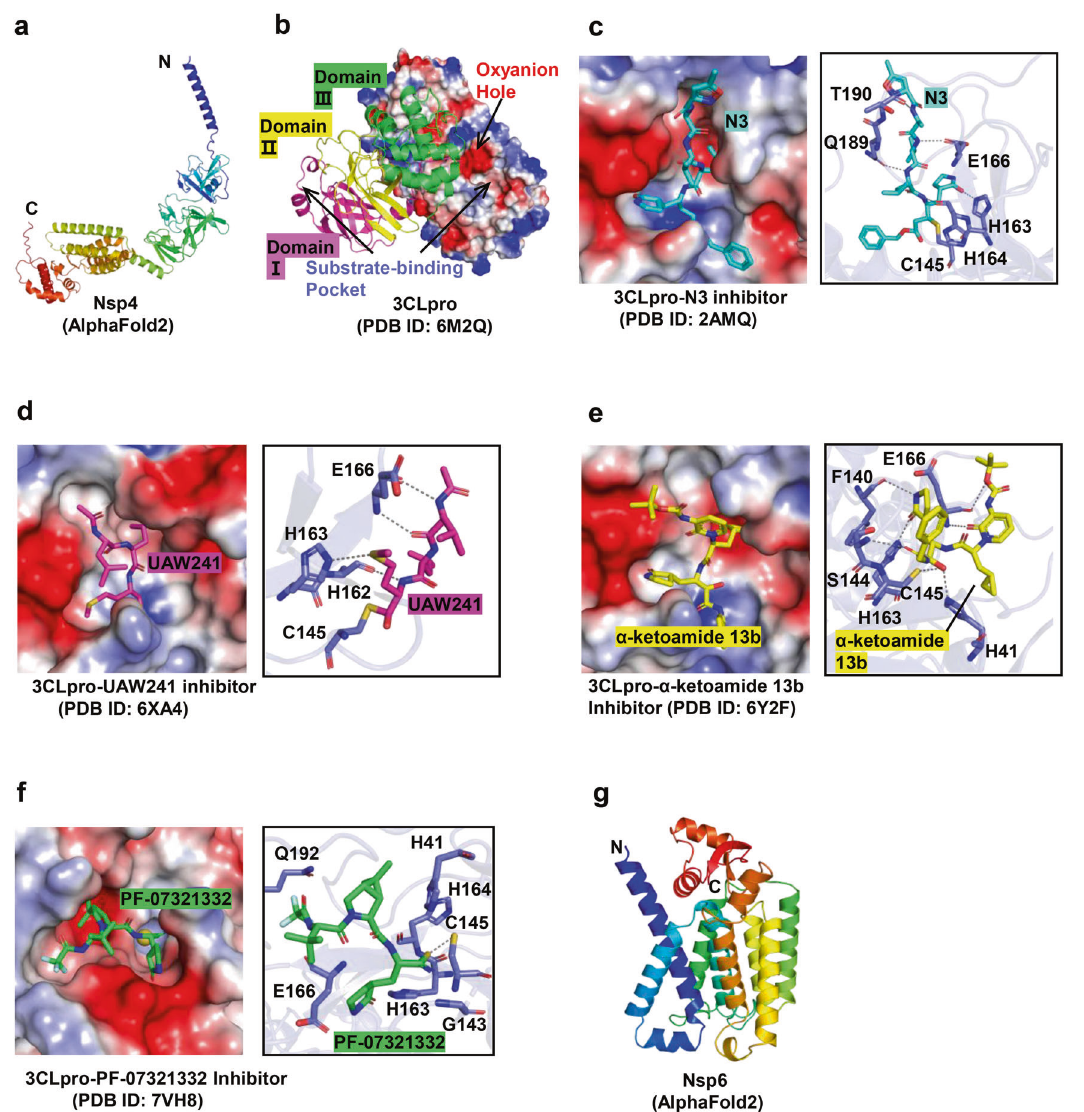
Fig. 5 Structures of Nsp4 /Nsp5 /Nsp6 and their inhibitors. a Predicted structure of Nsp4 protein. b Overall structure of 3CLpro protein with electrostatic surface and cartoon models. c – f Structures of 3CLpro in complex with N3, calpain inhibitor II (UAW241), α -ketoamide 13b inhibitors, and PF-07321332, respectively. g Predicted structure of Nsp6